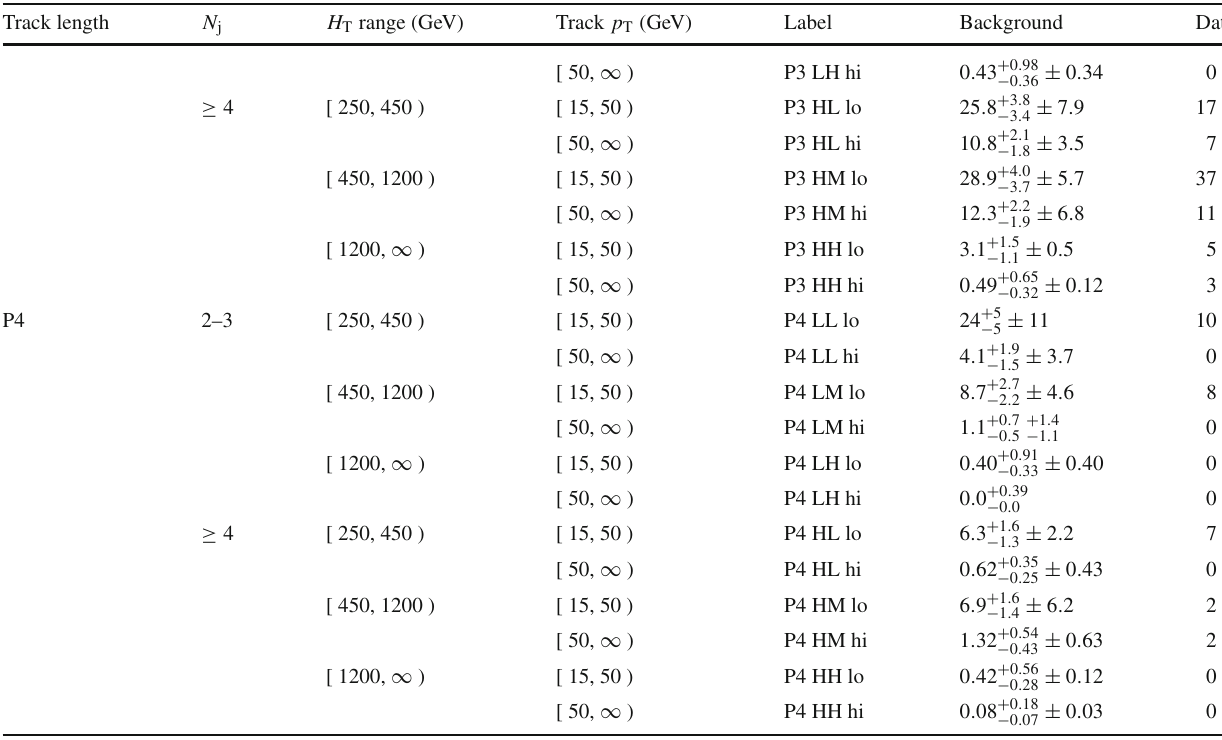
listed is statistical (from the limited size of control samples), and the second is systematic. The systematic uncertainty is not shown when